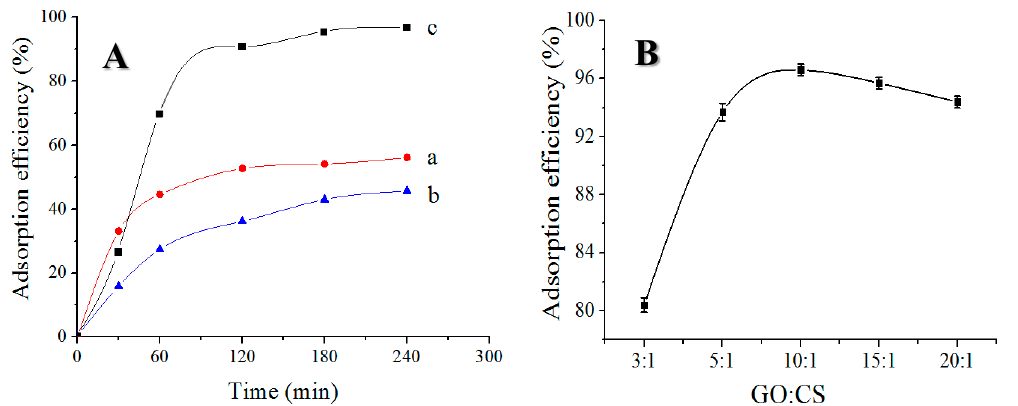
Figure 7. ( A )Effect of adsorbent types on adsorption properties of methyl orange: ( a ) CS aerogel, ( b ) GO aerogel, ( c ) CS/GO aerogel, and ( B ) effect of the raw material ratio on the adsorption performance of the CS/GO aerogel.